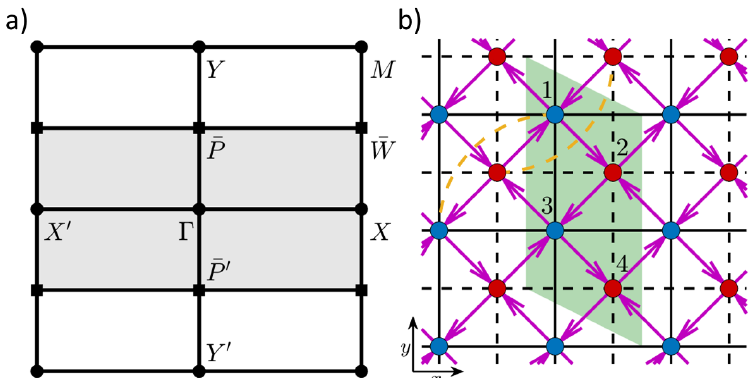
Figure 3: Brillouin zone for the square lattice models and real space representation of the Checkerboard lattice model. a) Square (white) and rectangular (grey shaded) BZ showing the high symmetry points in each one. The over-line in the high symmetry − direction. b) points denotes that they belong to the folded rectangular BZ in the k y Checkerboard lattice. Red and blue dots indicate the sublattice sites. The magenta arrow, black dashed (solid) line and yellow dashed line accounts for the nn hopping t , ( t (cid:48) ) and the nnnn hopping t (cid:48)(cid:48) respectively. The arrow direction the nnn hopping t (cid:48) 1 2 shows the sign of the accumulated phase φ in the nn hopping terms. The shaded green region in b) corresponds to the doubling of the original primitive cell which produces the folding of the square BZ into a rectangular one as indicated in panel